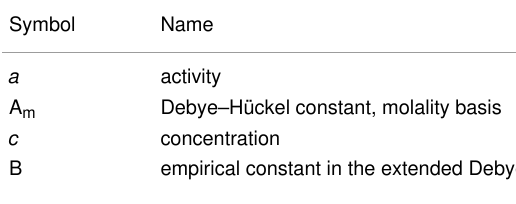
Table 1: Symbols with their names and units.